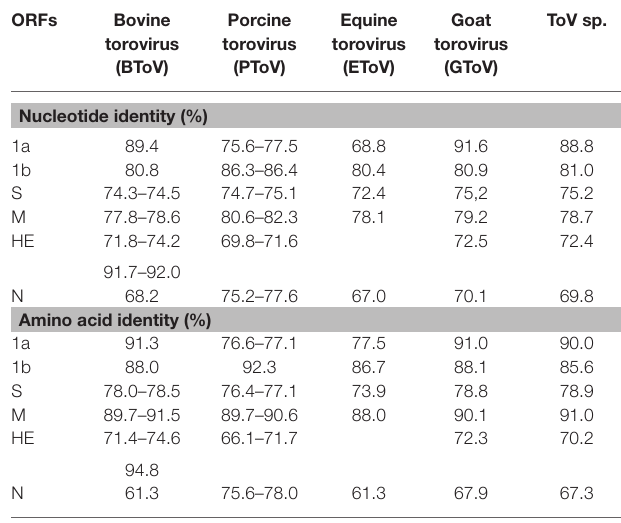
TABLE 1 | Pairwise nucleotide and amino acid sequences comparisons of six open reading frames (ORFs) of antelope torovirus (AToV) Qinghai1 and other Torovirus (ToV)